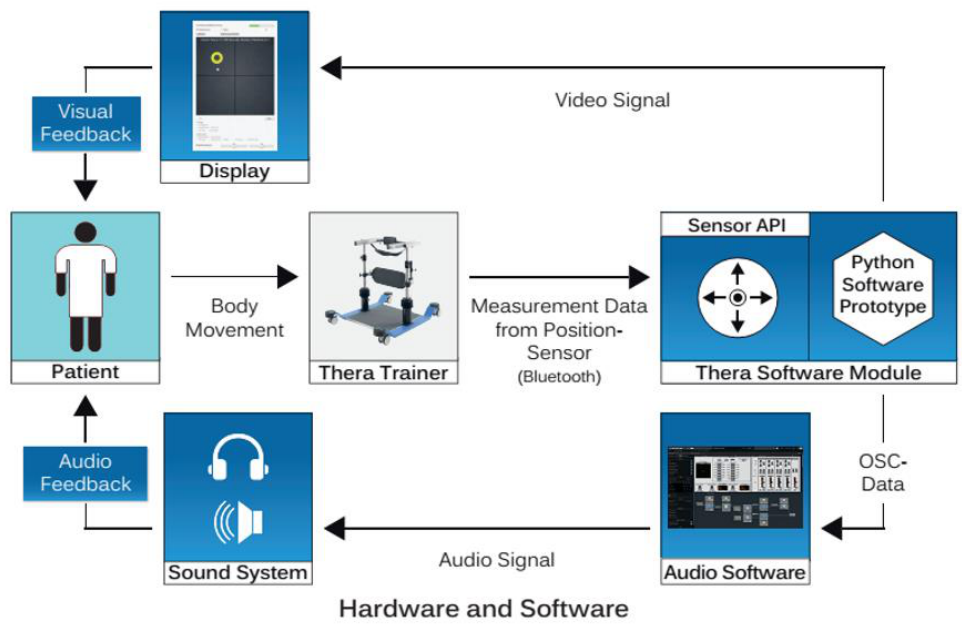
Figure 2. Experimental setup of hardware, software, and feedback.